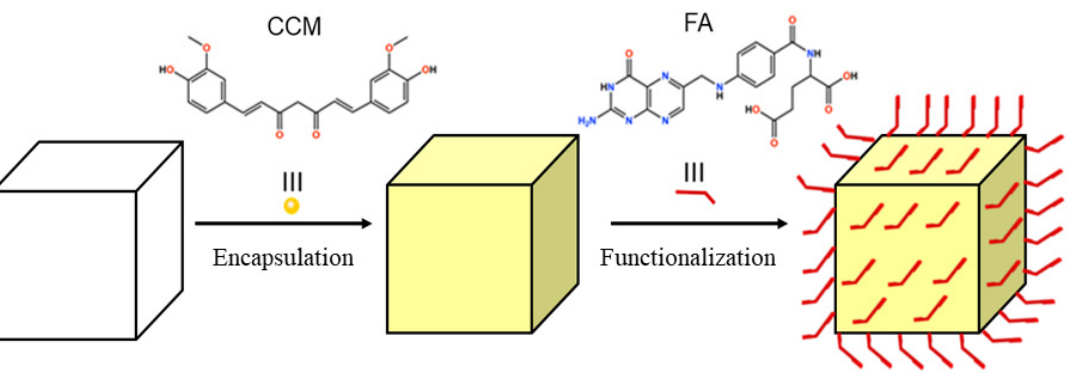
Figure 12. Representation of FA molecules on the surface of the matrix containing the drug.